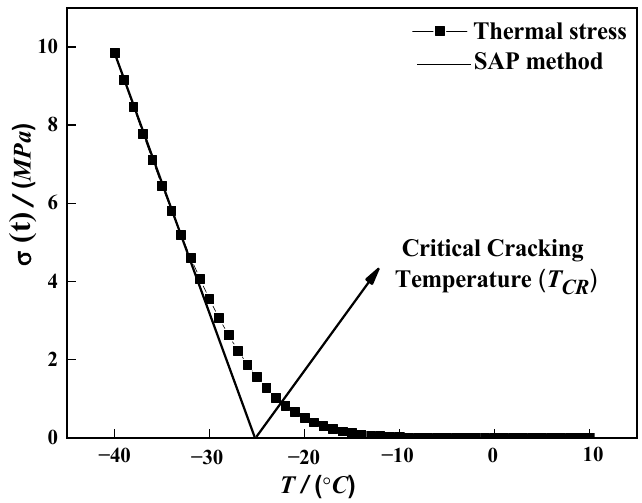
Figure 3. Single asymptotic procedure [20].